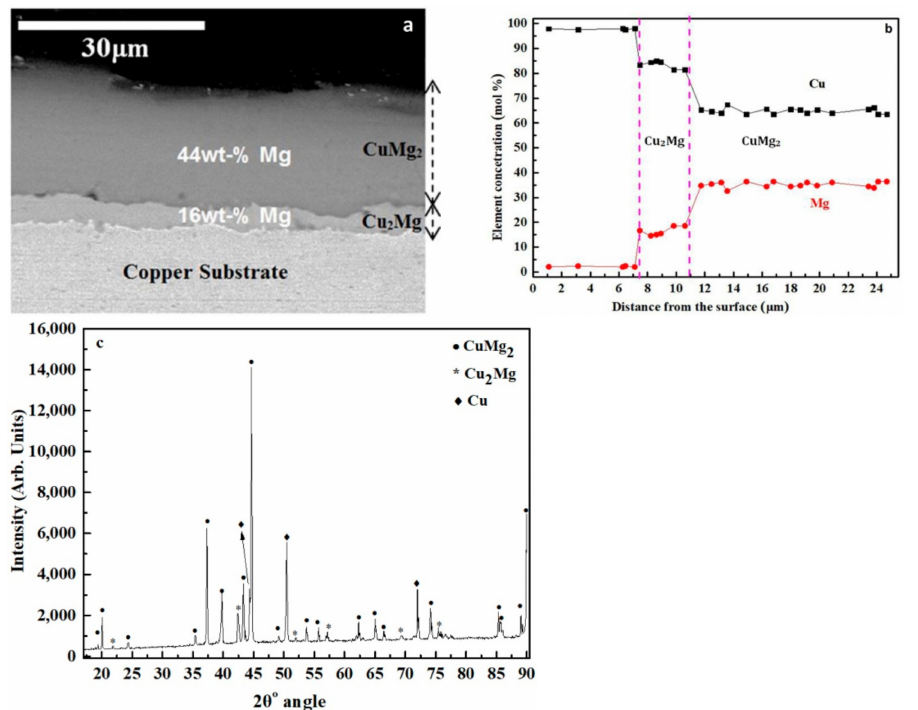
Figure 1. SEM micrograph of Mg pack coatings formed on copper at 550 ◦ C for 2 h ( a ), corresponding Energy Dispersive Spectroscopy (EDS) line scanning ( b ) and XRD pattern ( c ) (The identification was accomplished by using the following JCPDS Cards: #65-1116 for CuMg 2 , #77-1178 for Cu 2 Mg and #85-1326 for Cu).